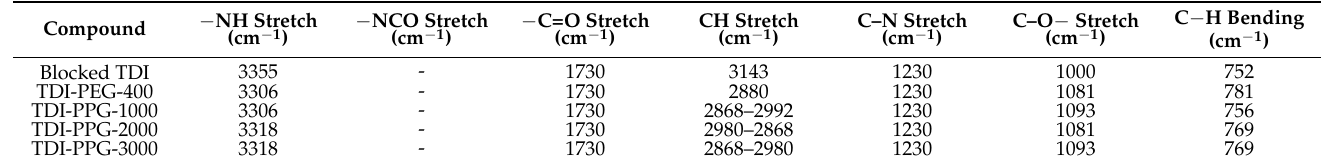
Table 6. FTIR spectral data of blocked TDI and the polyurethane from it.